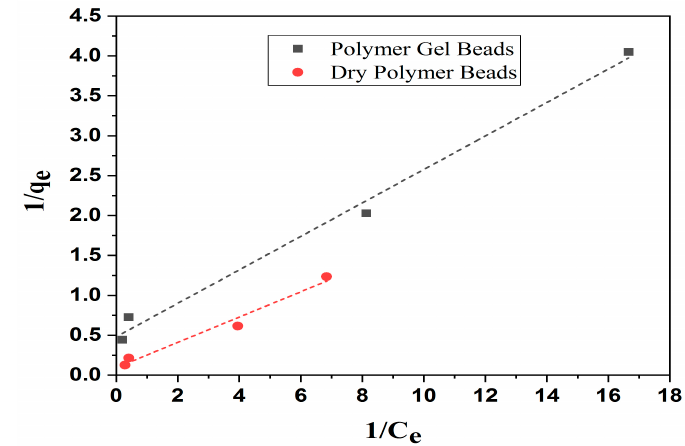
Figure 9. Langmuir adsorption isotherm fitting on data for MB adsorption on Fe 3 O 4 /AC/CD/Alg polymer gel beads and dry powder polymer beads.